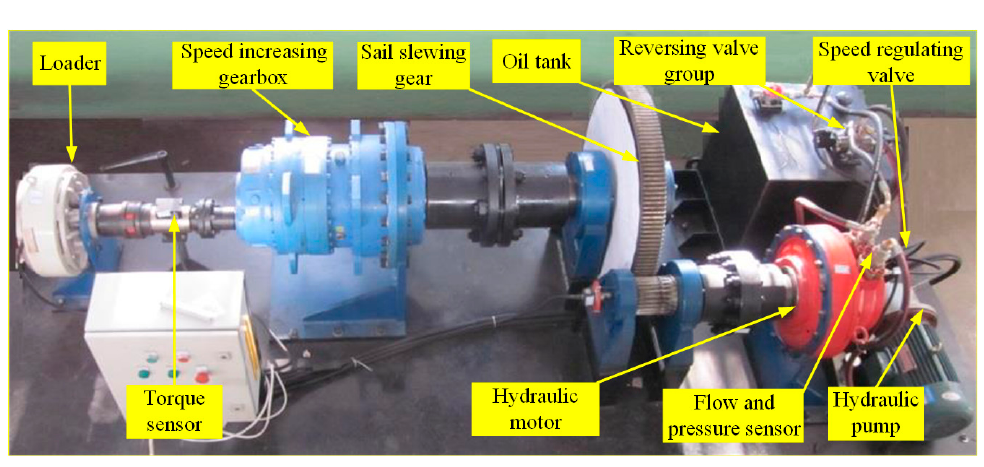
Figure 6. Sail slewing hydraulic testbed.